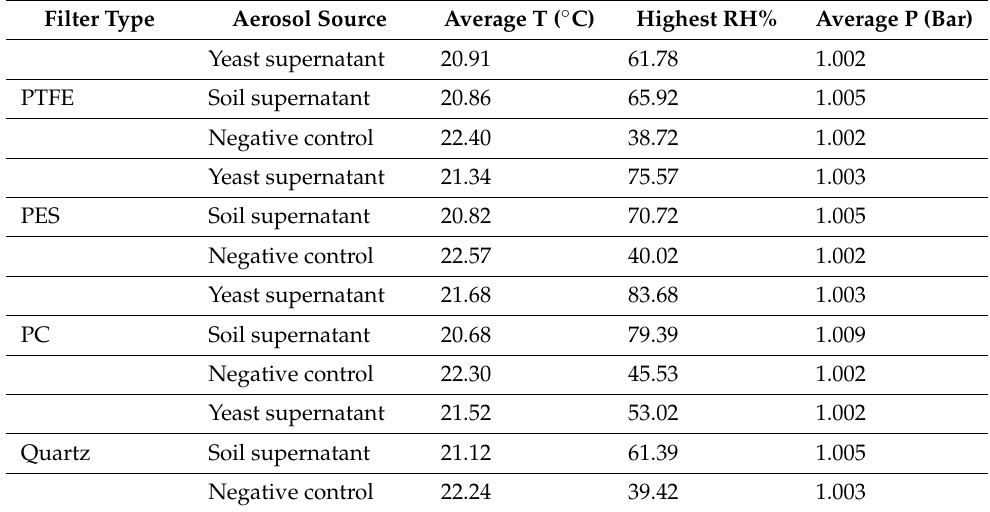
Table 3. Environmental parameters during the experiments inside the bioaerosol chamber. Filter